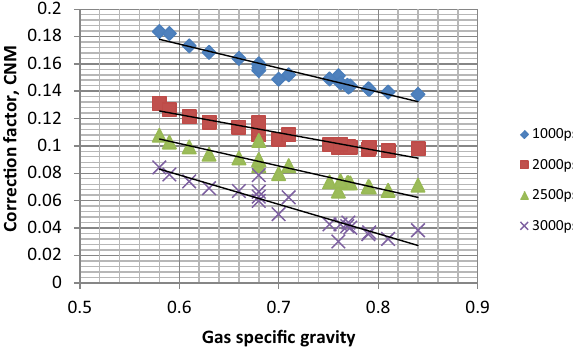
Fig. 10 Calculation of C NM at 280 (cid:3) F and different